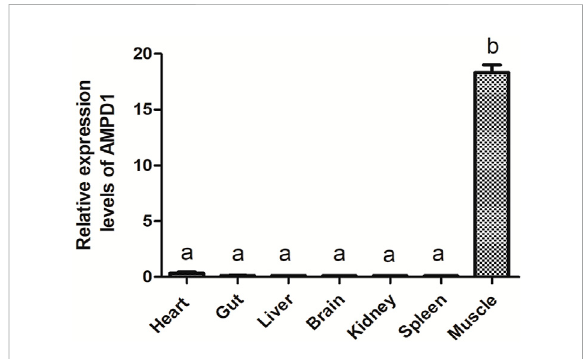
FIGURE 3 The relative expression levels of AMPD1 gene in different tissues of triploid crucian carp were analyzed by real-time fl uorescence quantitative PCR. Error bars represent the means ± SD; n = 3. p < 0.05.